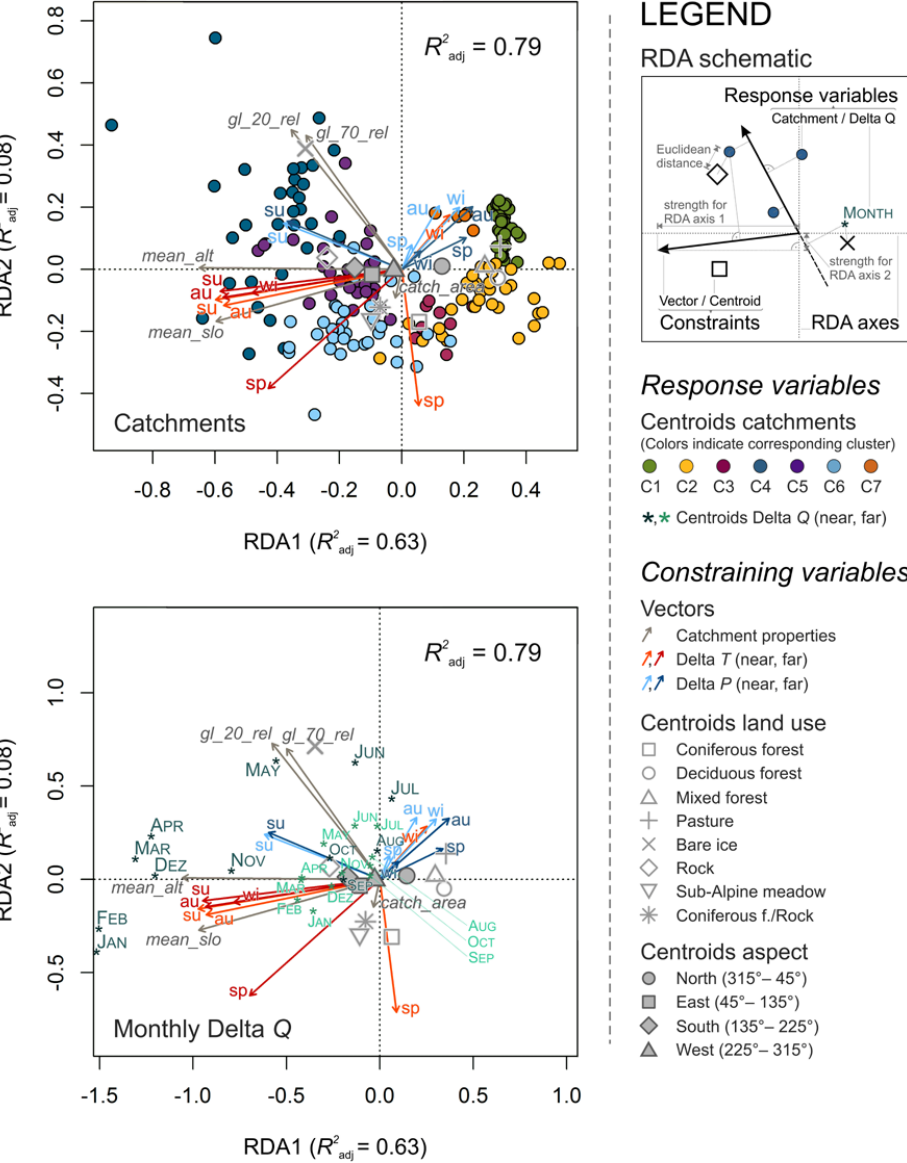
Fig. 6. RDA-biplots for all catchments and both scenario periods. At the top of the legend, a schematic of an RDA with its different components is given (cf. Sect. 4.2 for interpretation rules). The upper panel shows a biplot of the catchments; the lower panel displays the same results but with respect to monthly runoff changes (Delta Q ). The vectors of the seasonal Delta T and P are indicated with abbreviations “wi”, “sp”, “su” and “au”. Both change signals are displayed for the near (orange and light blue) and the far (red and dark blue) future. The ) is the proportion of variance of the response variables explained by the constraining adjusted R 2 ( R 2 adj